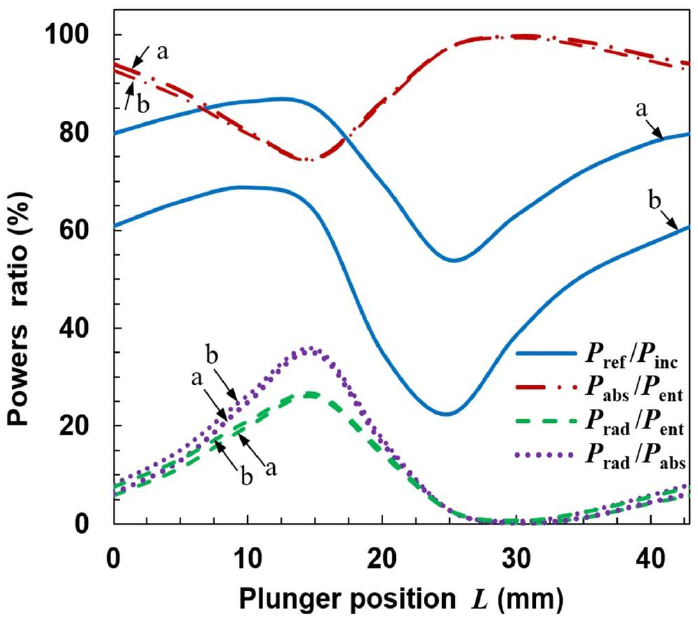
Figure 18. Dependence of powers ratio on movable plunger position for closed configuration, s = 10 and two values of the electron density. a: n e = 1 × 10 20 m −3 and b: n e = 1 × 10 21 m −3 .